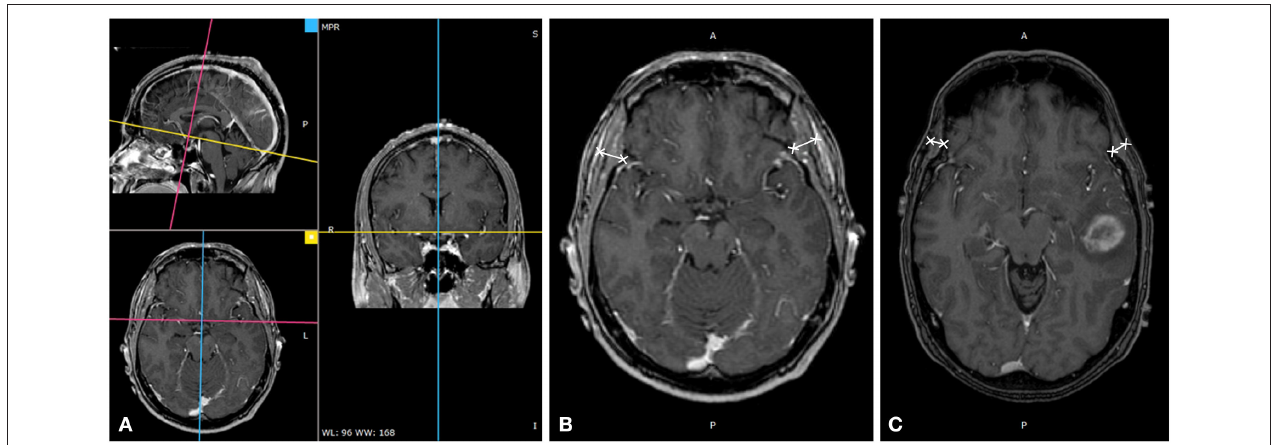
FIGURE 1 | Temporal muscle thickness (TMT) measurement on cranial MRI. (A) TMT measurement on cranial thin T1WI contrast-enhanced image through multiplanar reformation, (B) A 49-year-old male patient with an overall survival of 38.1 months (bilateral mean TMT = 10.20mm), and (C) a 57-year-old male patient with an overall survival of 16.9 months (bilateral mean TMT = 5.94mm).